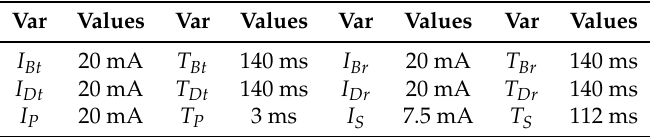
Table 1. Simulation environment.